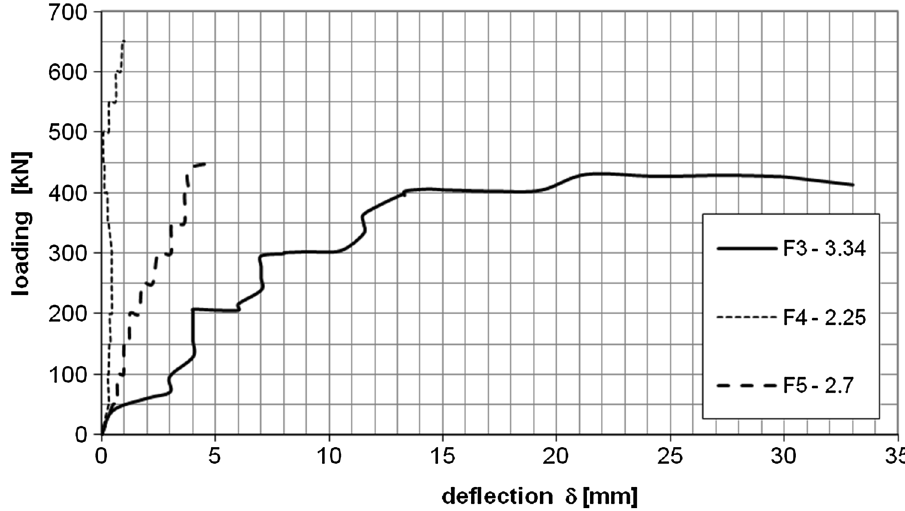
Fig. 16 Dependence of the punching capacity on the shear slenderness.